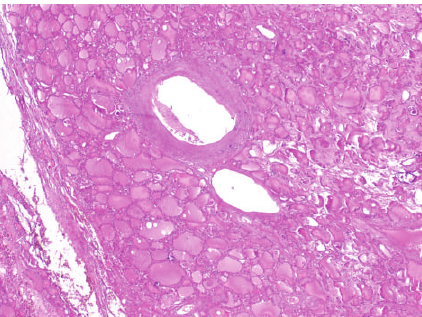
Figure 2: The thyroid nodule is seen apparently seperated from the surrounding thyroid tissue. The nodule shows follicular patterns of di ff erent sizes not compressing the surrounding tissue. Eosinophilic and hyaleneceous amorphous substance accumulation is seen in the arterial wall and interstitium compatible with amyloid (H & E).